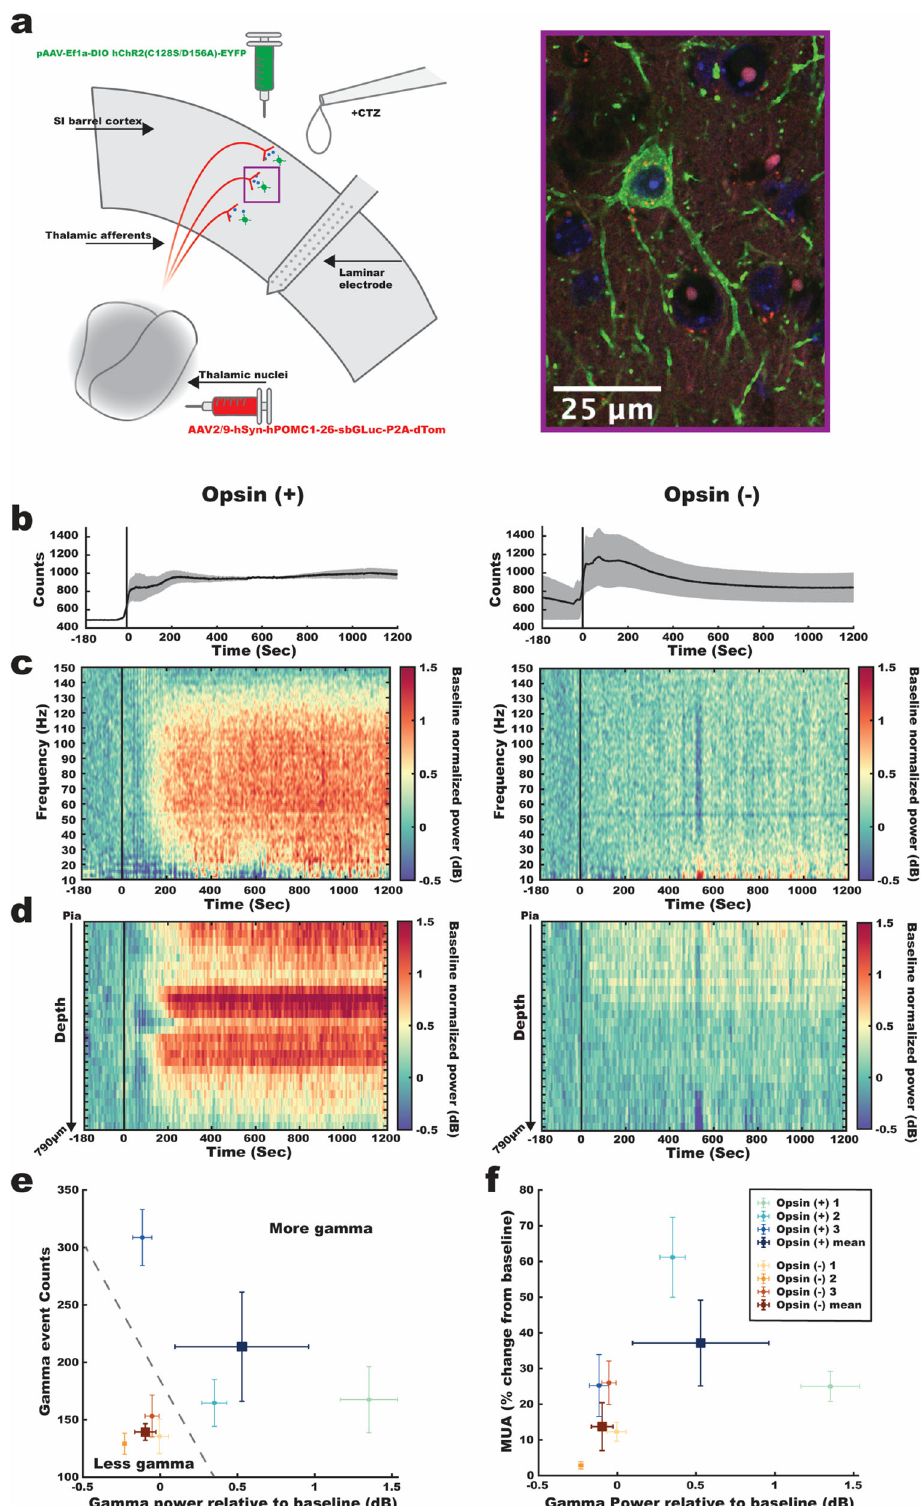
control group, despite robust bioluminescent photon output. These Interluminescence gamma increases were localized to more super fi cial and granular layers across the neocortical depth and were evident on ~half of all electrode contacts in the Opsin ( + ) group (Fig. 7d : Opsin ( + ) = 15.7 ± 10.1 SD electrodes/mouse; Opsin ( − ): M = 2.7 ± 2.5 SD; Supplementary Data